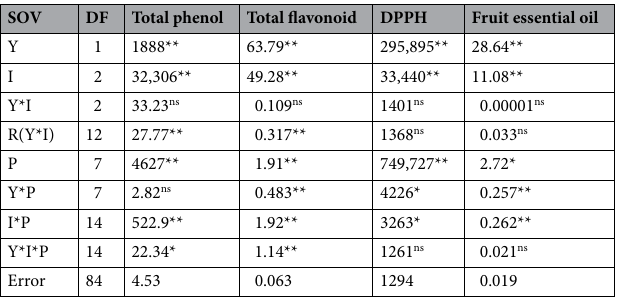
Table 1. Analysis of variance (mean squares) for phytochemical traits of 24 Moshgak populations (P) evaluated at three levels of irrigation (I) and 2 years (Y) of 2019 and 2020. DF: degrees of freedom; ns, non- significant; *, significant at P ≤ 0.05; **, significant at P ≤